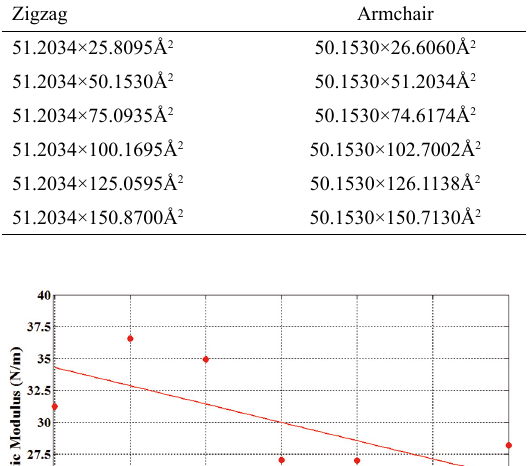
Table 2: Dimensions of armchair and zigzag nanosheets with the aspect side length of 50 Å Zigzag